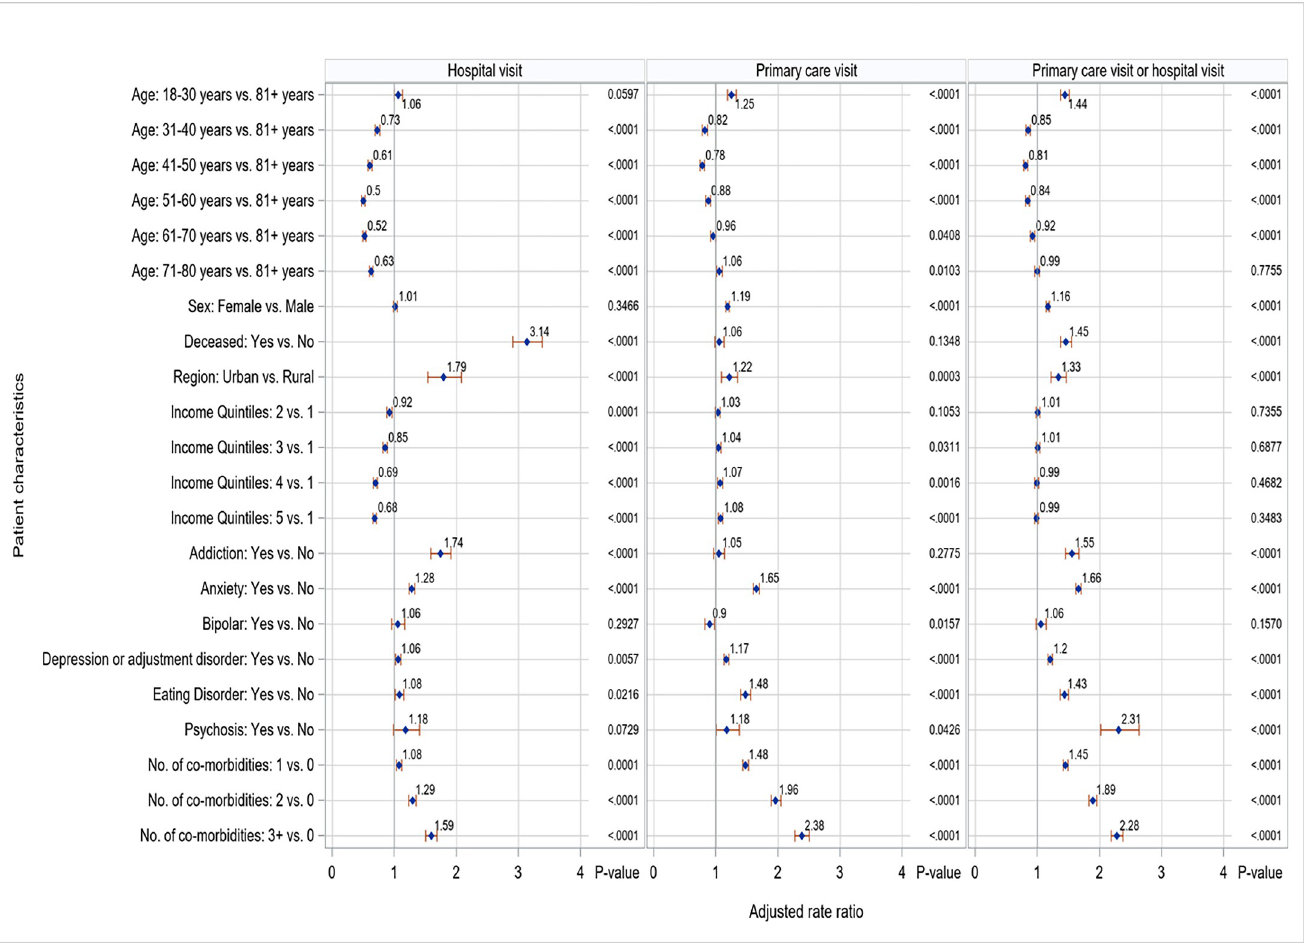
Fig 2. Adjusted rate ratios for health care utilization in hospital and primary